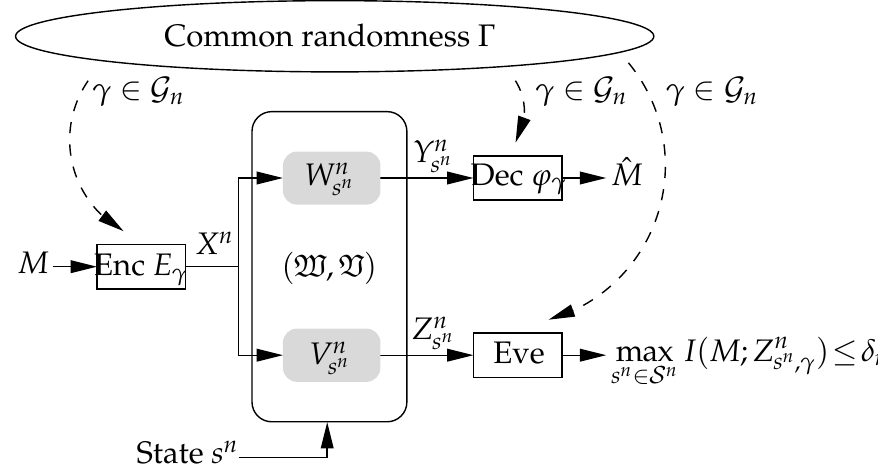
Figure 2. CR is available to all users including the eavesdropper. The transmitter and receiver can adapt their encoder and decoder according to the actual CR realization γ ∈ G n